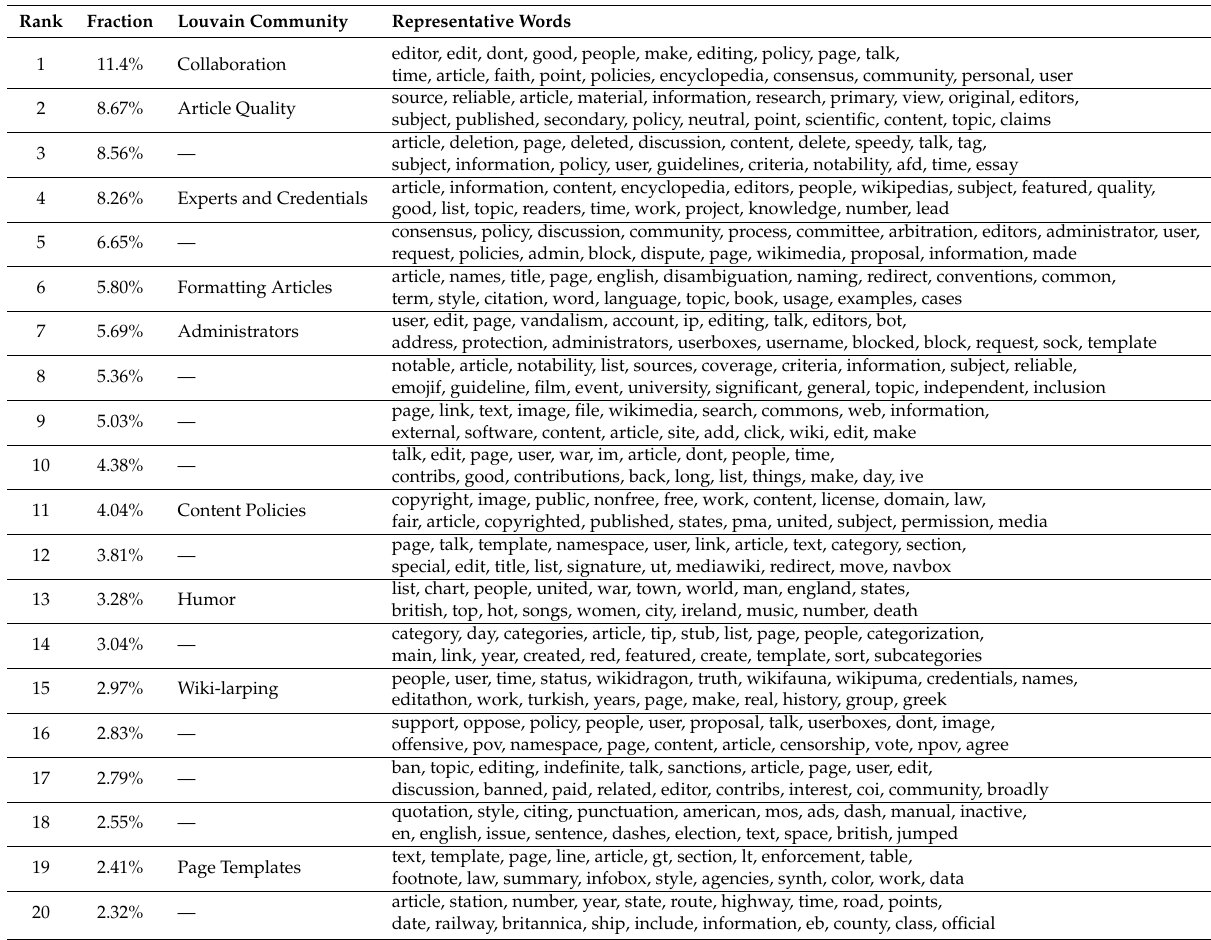
Table F.1. Representative one-grams from each of the topics in our k = 20 topic model, ranked by the weighted fraction of words assigned. The top nine Louvain clusters are each dominated by a unique